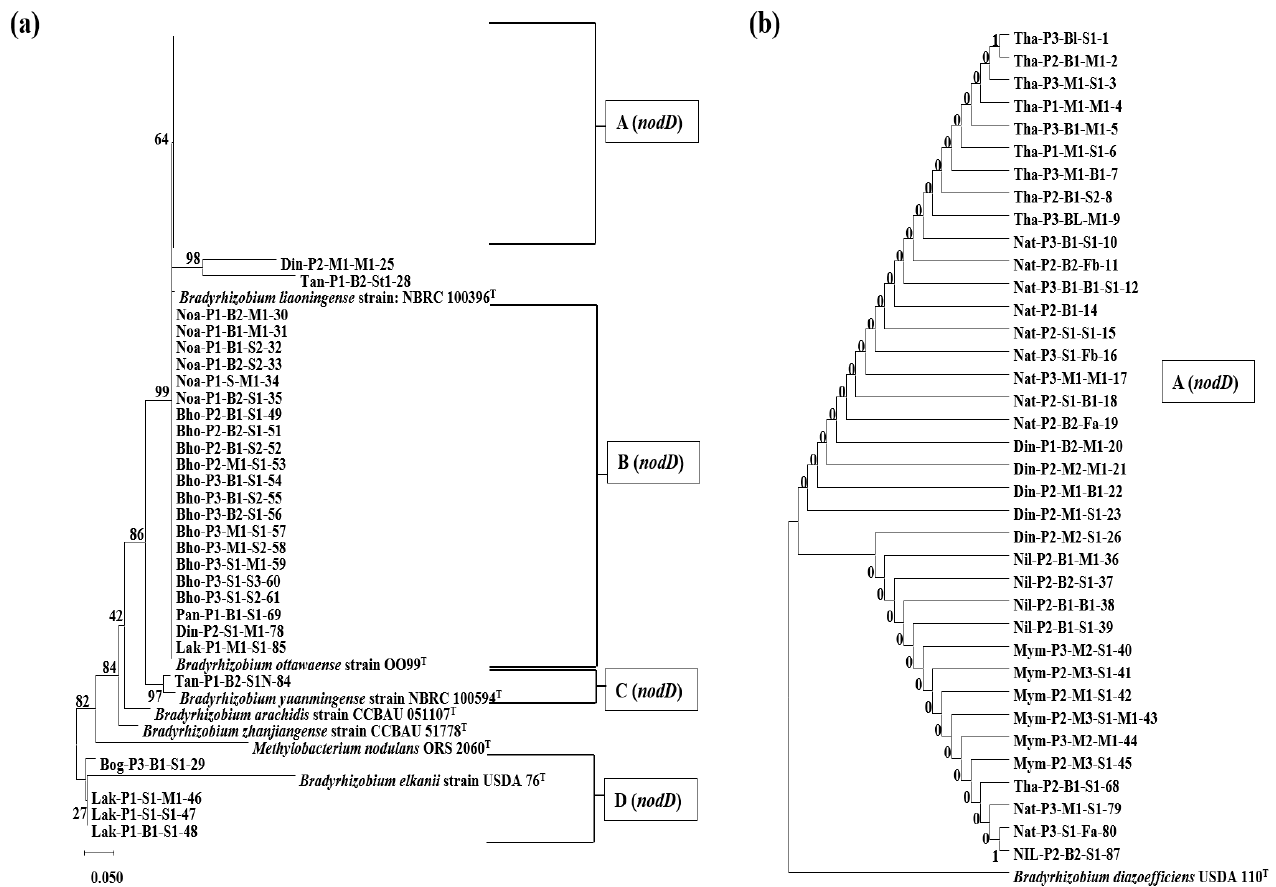
Figure 4. Phylogenetic analysis of the nodD1 gene of isolated bacteria with reference strain. The percentage of trees in which the associated taxa clustered together after 1000 Bootstrap replications is shown next to the branch points. ( a ) Main tree with one compressed sub-tree has been shown with ( b ) the respective sub-tree.